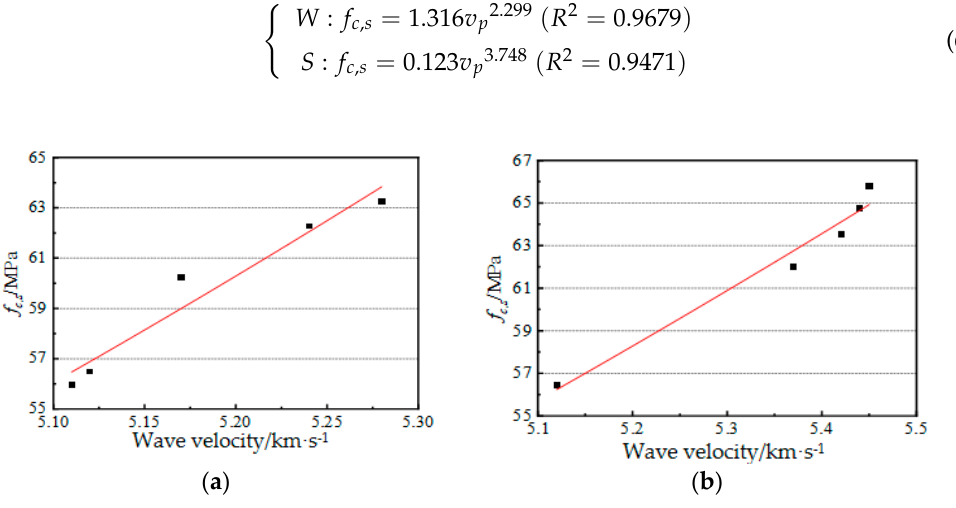
Figure 10. Fitting curve of the static compressive strength and wave velocity for the test pieces ( a ) the W group; ( b ) the S group.